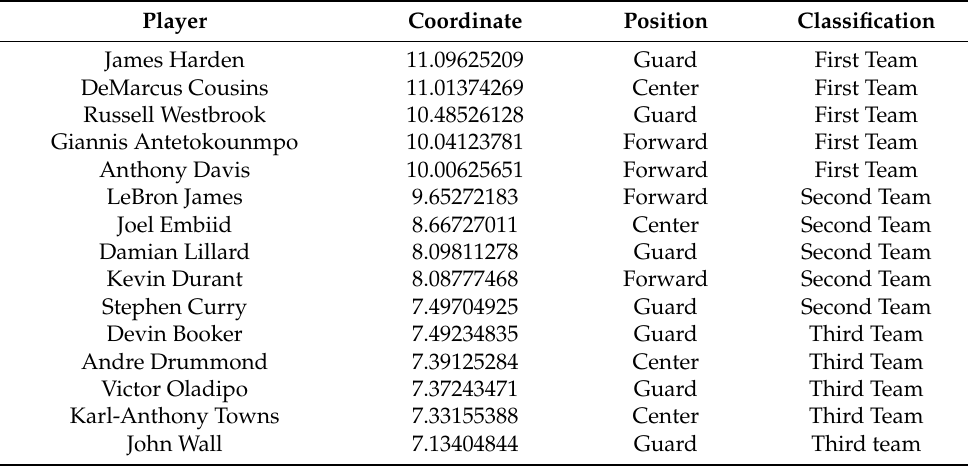
Table A5. All-NBA Teams’ selection through PC1, 2017–18 NBA Season.